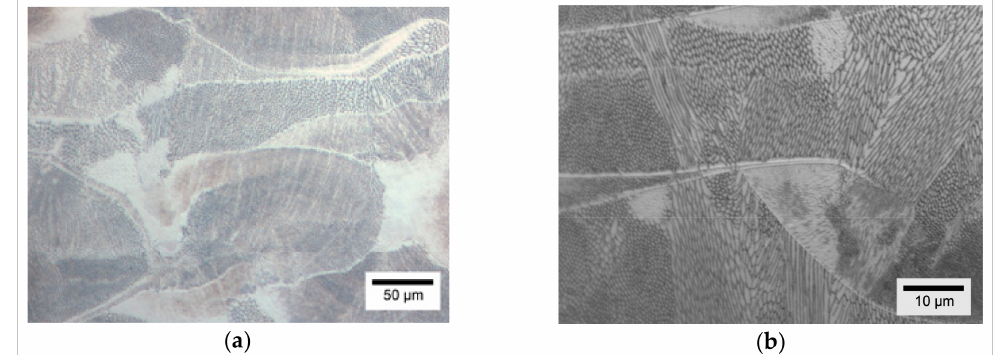
Figure 6. Close inspection of the 0 ◦ hatch angle, y-direction specimen showing the cellular structure and melt pool boundary, at two di ff erent magnifications: ( a ) 50 µ m and ( b ) 10 µ m.